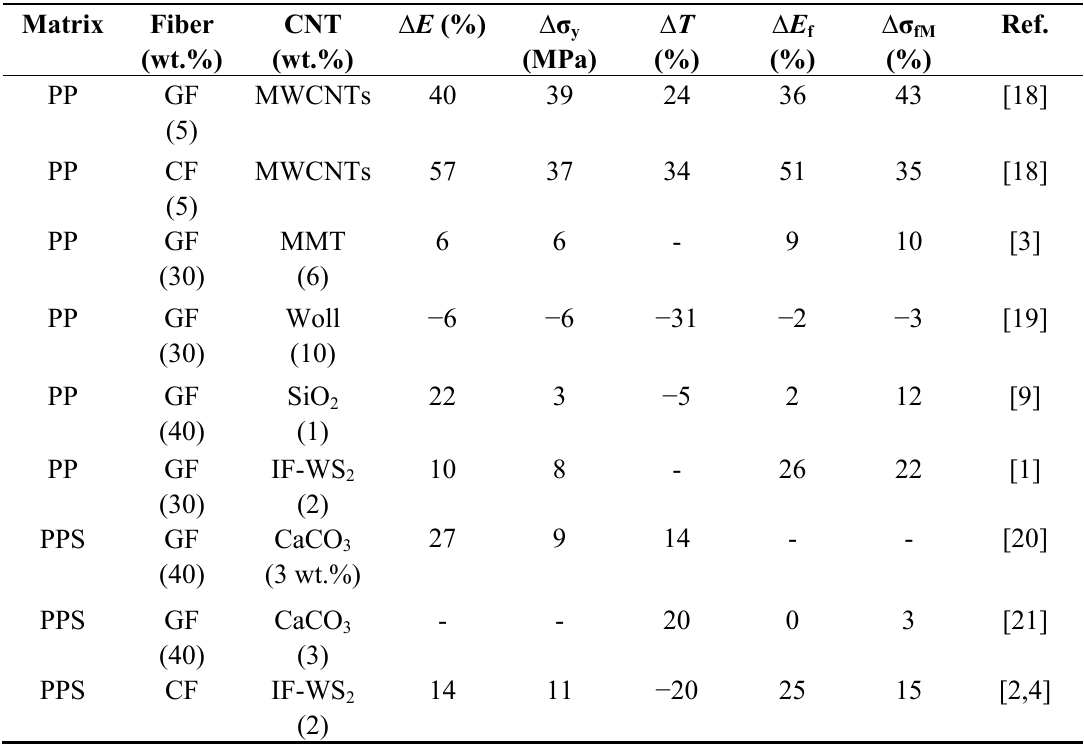
Table 2. Comparison of the increment in static mechanical properties (in %) for different polypropylene (PP) and polyphenylene sulfide-(PPS) based hierarchical laminates. MWCNT: multi-walled carbon nanotubes; MMT: montmorillonite; Woll: